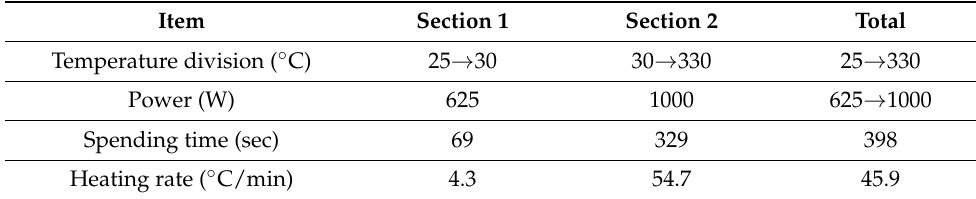
Table 2. Heating rate test of the PHC heating part.